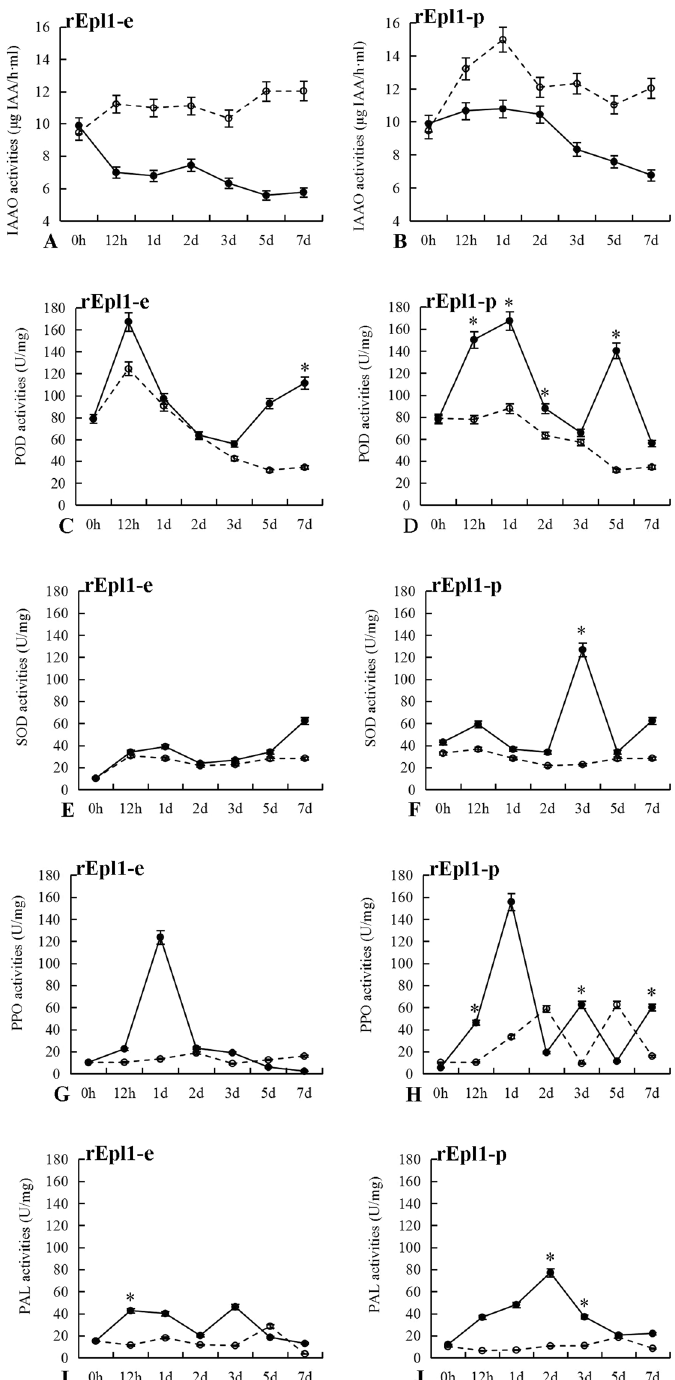
Figure 8. The activities of five kinds of enzymes in Populus davidiana × P . alba var. pyramidalis (PdPap) seedlings leaves under rEpl1-e or rEpl1-p induction. X-axis: time points, Y-axis: enzyme activities, namely IAAO ( A , B ), POD ( C , D ), SOD ( E , F ), PPO ( G , H ), and PAL ( I , J ) activities in PdPap seedlings leaves under rEpl1-e or rEpl1-p induction, respectively. Solid lines: the treatment group; dotted line: the control group. * Significant difference between rEpl1-e and rEpl1-p treatments at the same time point ( p < 0.5). All experiments were performed three